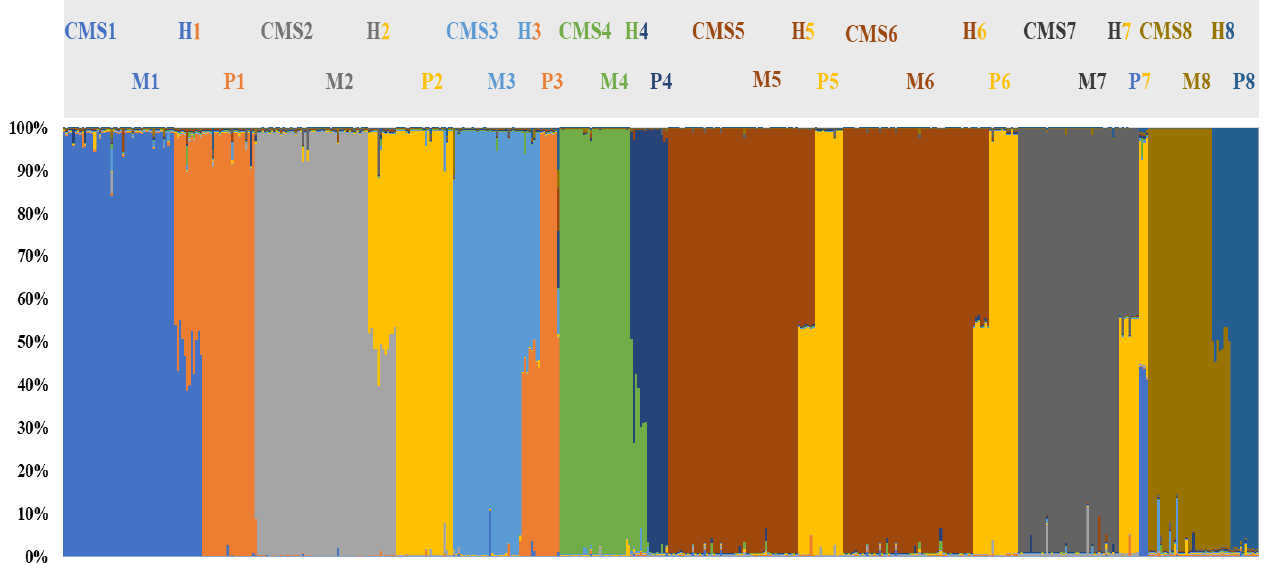
Figure 4. ∆ K estimation from STUCTURE Harvester web software elaboration of the STRUCTURE software results. The most probable value of K was equal to 11.